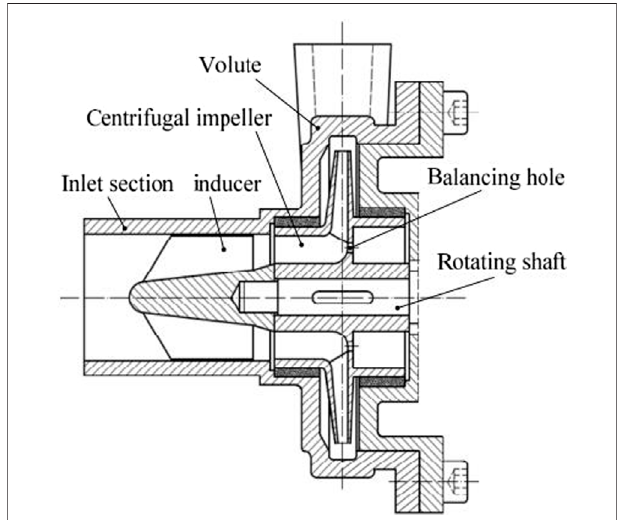
FIGURE 5 | Pressure and gas phase distribution diagrams of the pump before and after designing the hole (Hao Gao, 2020).